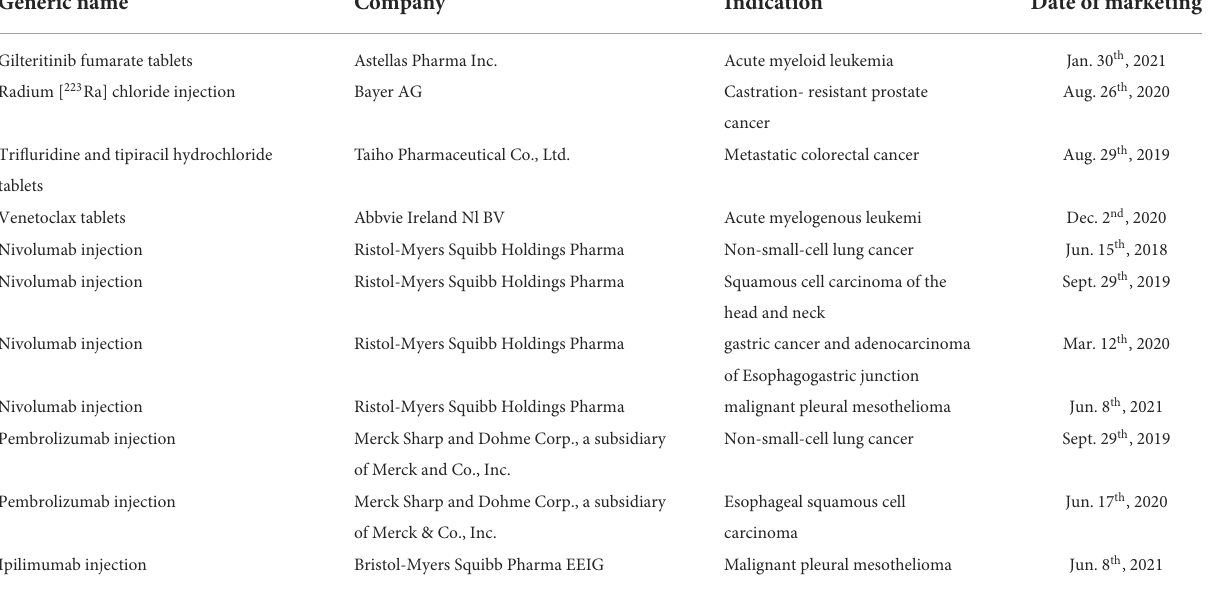
TABLE 5 List of drugs failed the NRDL admission by using OS as the primary